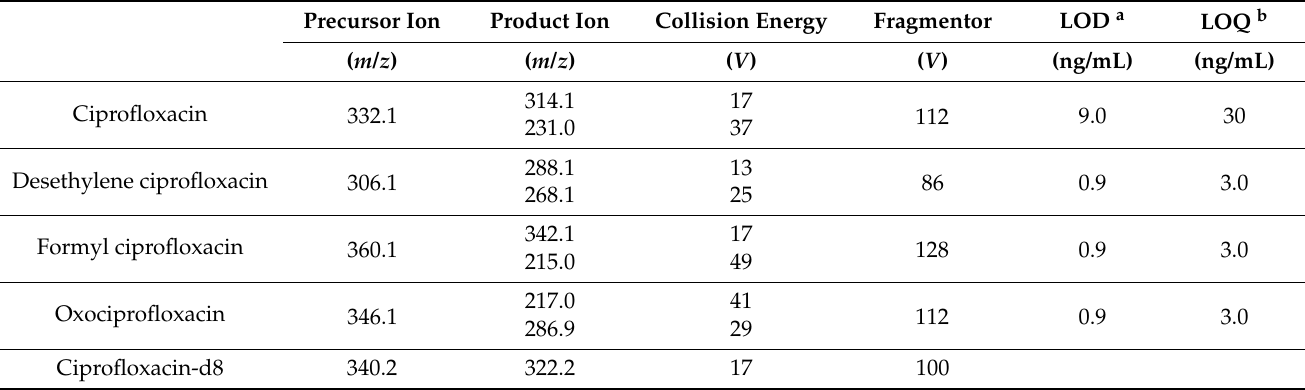
Table 1. UHPLC-MS/MS parameters of the analyzed